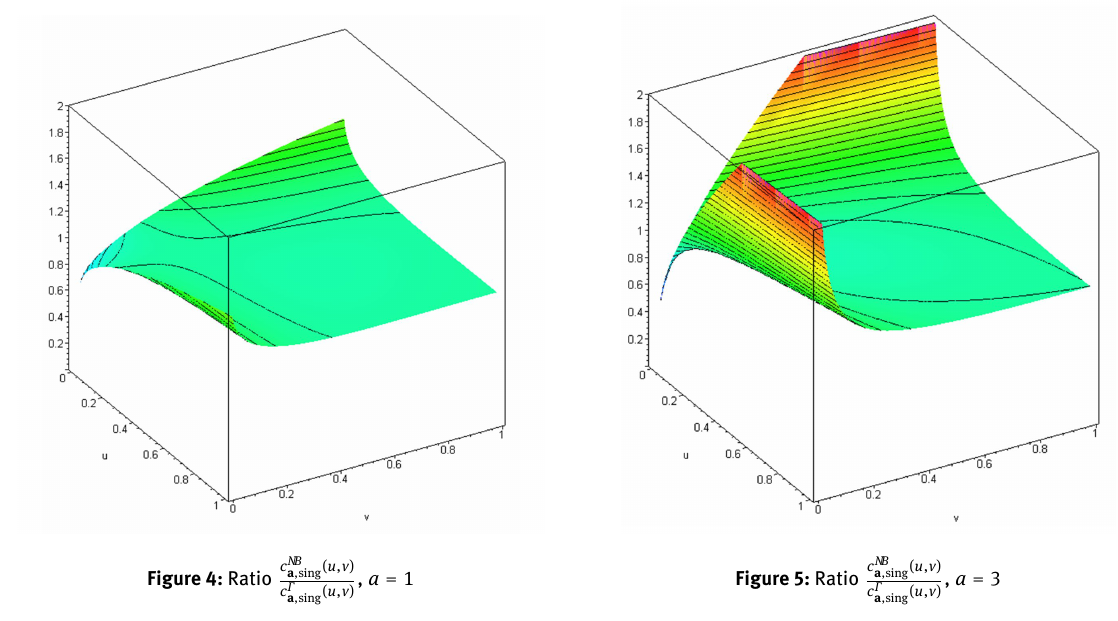
c NB a ,sing ( u , v ) , a = c Γ a ,sing ( u , v )